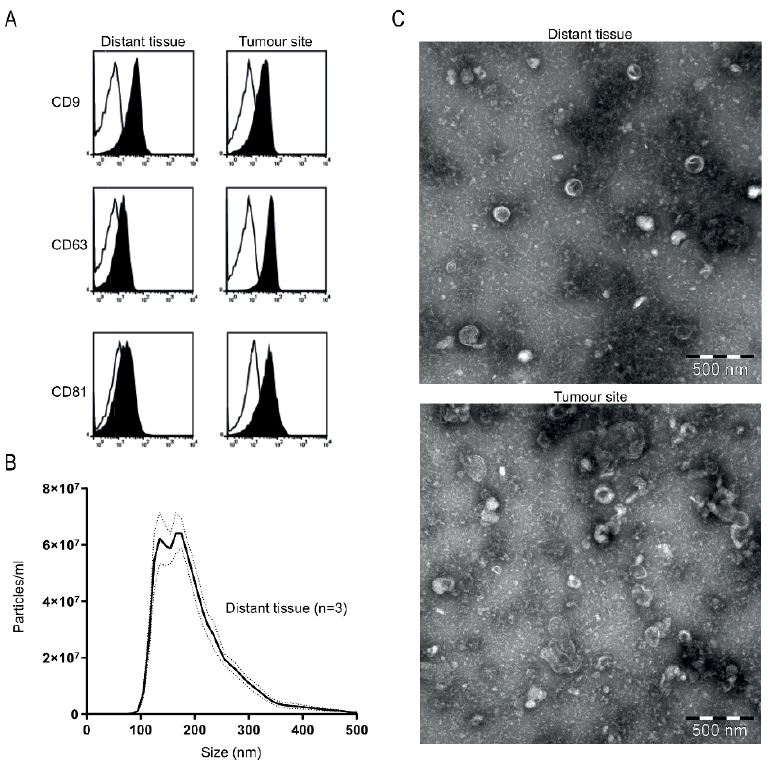
Figure 1. Phenotypic analysis of tissue explant-derived exosomes. ( A ) Exosomes from tissue were bound to anti-human CD63 latex beads, stained for CD9, CD63 and CD81 and analysed by flow cytometry. The histograms are representative of n = 2 (black represents marker, line the corresponding isotype control). ( B ) Nanoparticle tracking analysis of exosomes isolated from distant bladder tissue. Data are shown as an average of n = 3 and dotted lines indicate ± standard error of the mean. ( C ) Representative transmission electron microscopy images of tissue-derived exosomes isolated from distant bladder tissue (top) and original tumour site (bottom); bar equals 500 nm.